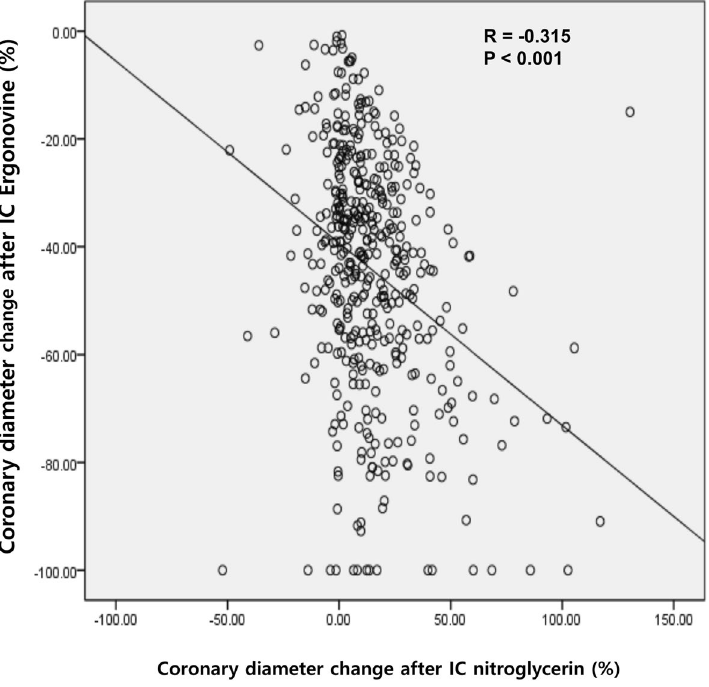
Figure 2. Correlation between coronary response to ergonovine and nitroglycerin. Abbreviations: IC intracoronary.